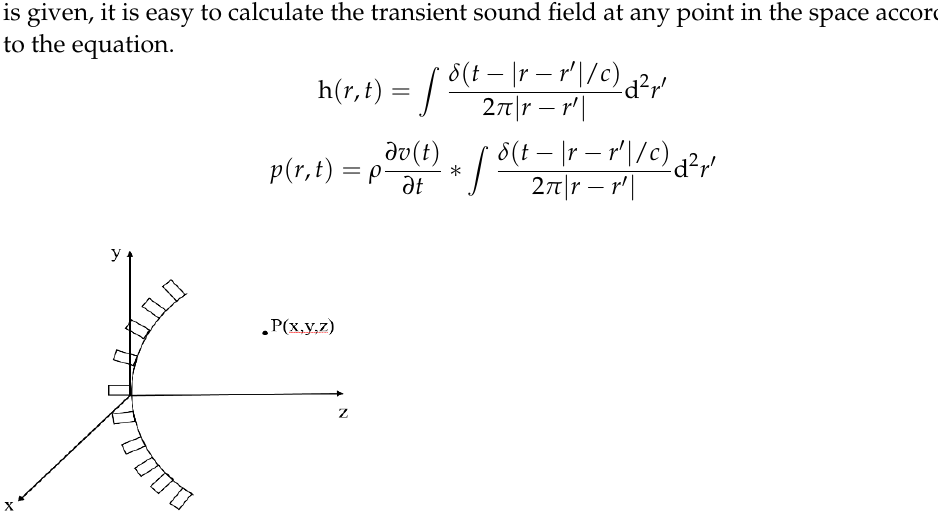
Figure 8. Influence of different filling forms on thickness.